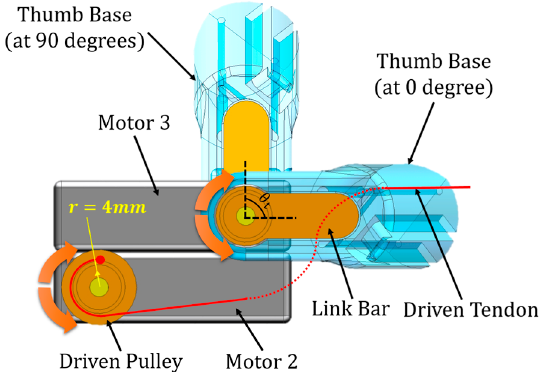
Figure 9. Motor configurations for thumb.